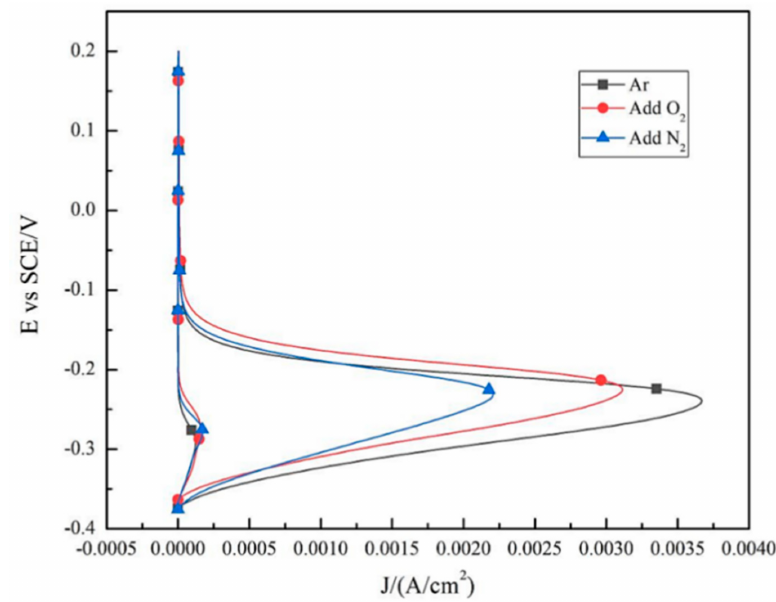
Figure 11. DL-EPR test for the welded joints under different shielding gases.